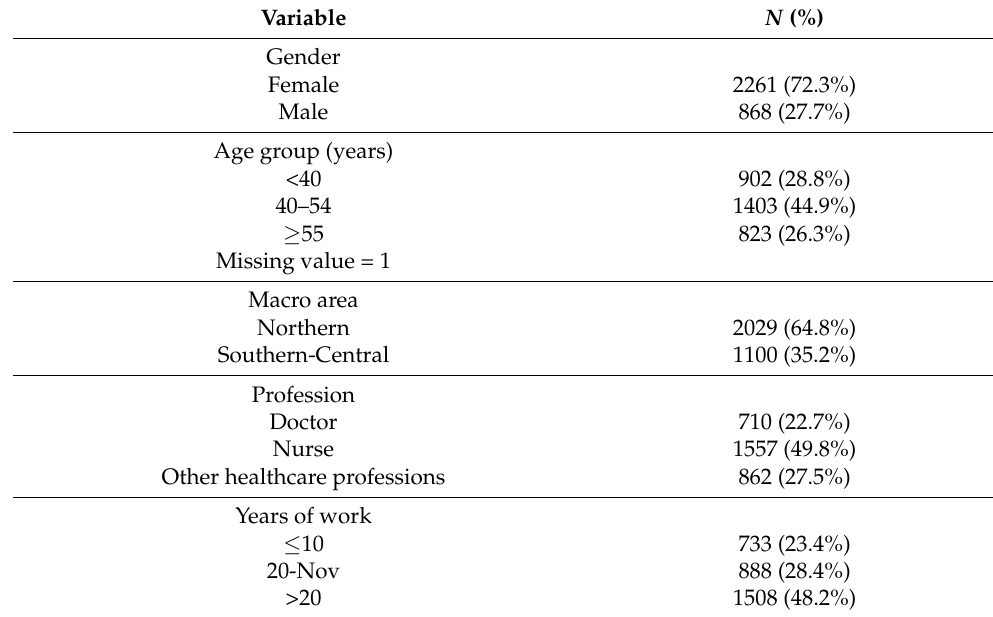
Table 1. Characteristics of the sample